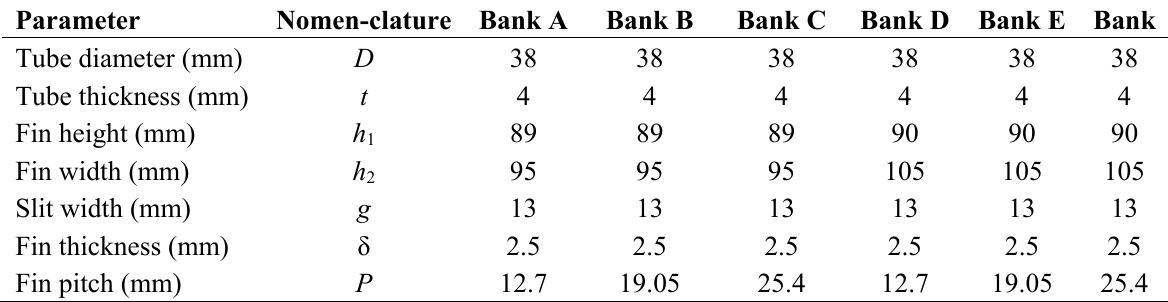
Table 1. Main geometry data for testing H-type finned tube